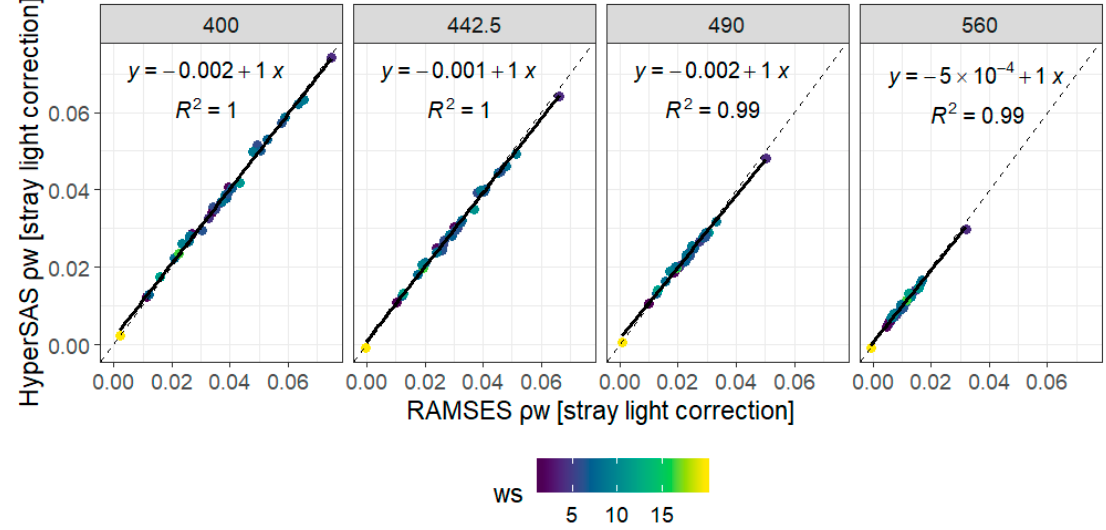
Figure 17. Correlation between HyperSAS and RAMSES measured water-leaving reflectance after stray light correction on selected wavelengths. Colour is wind speed (m s − 1 ) during the measurement.